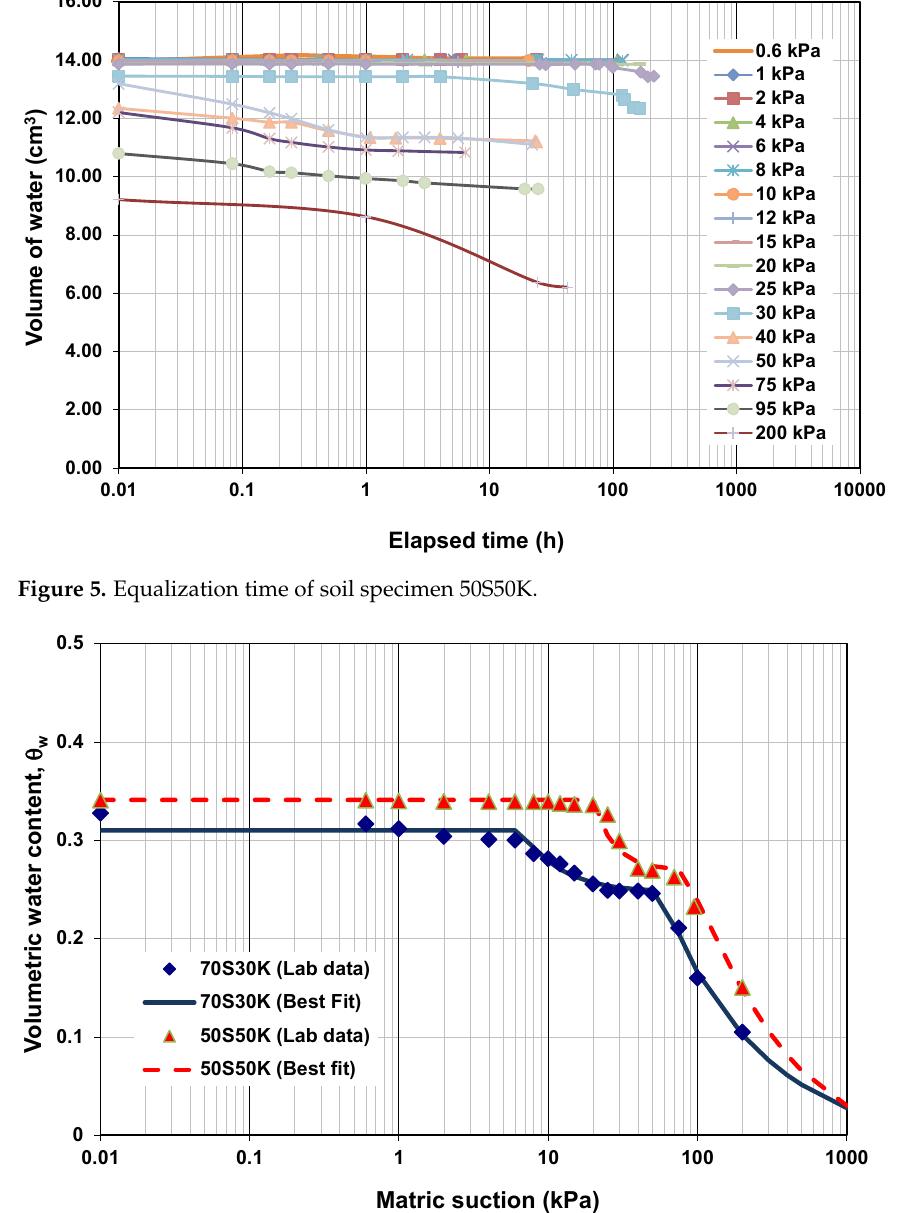
Figure 6. WRC of 70S30K and 50S50K. Table 3. WRC fitting parameters based on bimodal equation proposed by Satyanaga et al. [17].